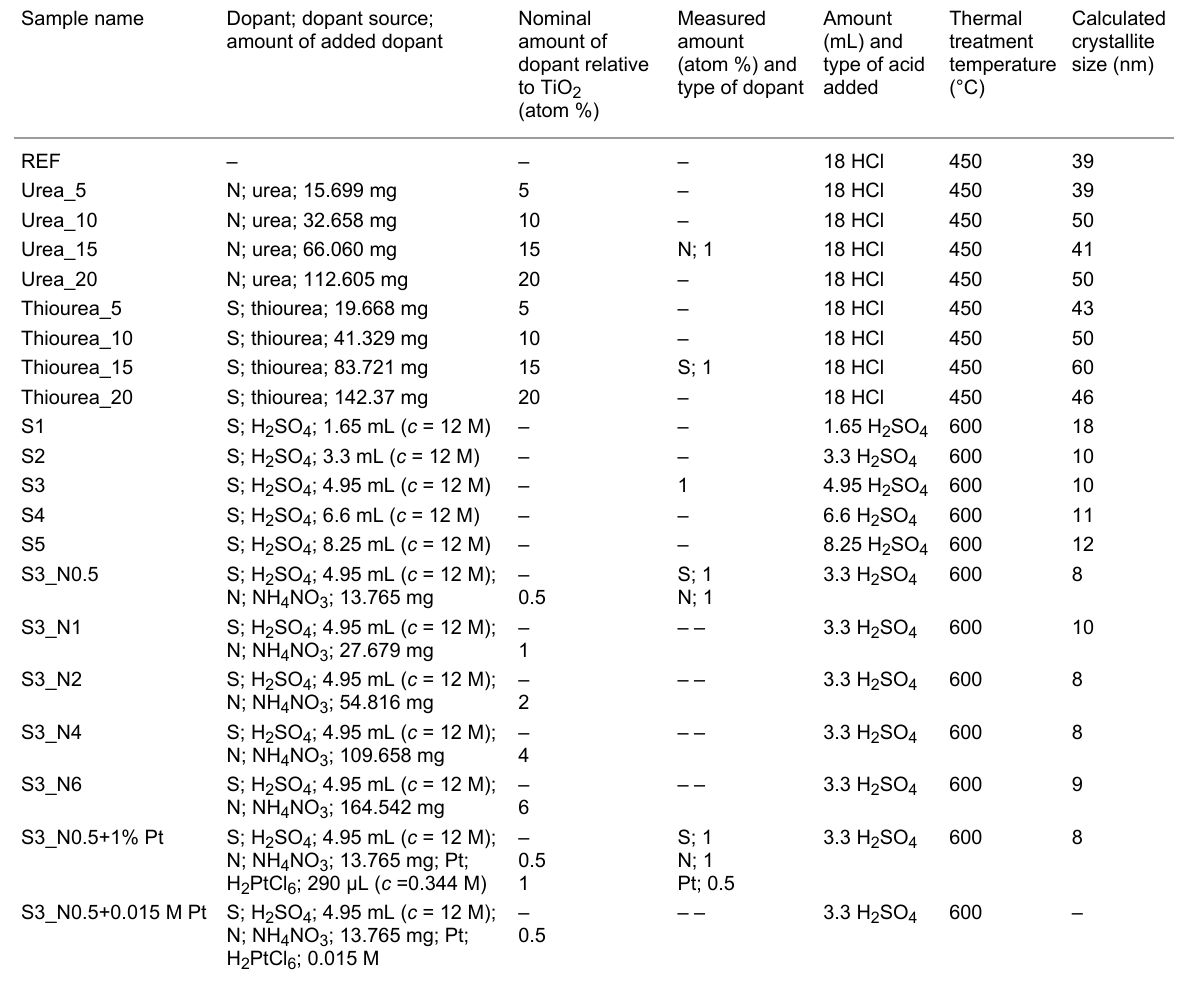
Table 1: Sample labels, types and amounts of added dopants, thermal treatment temperatures and calculated crystallite sizes for different